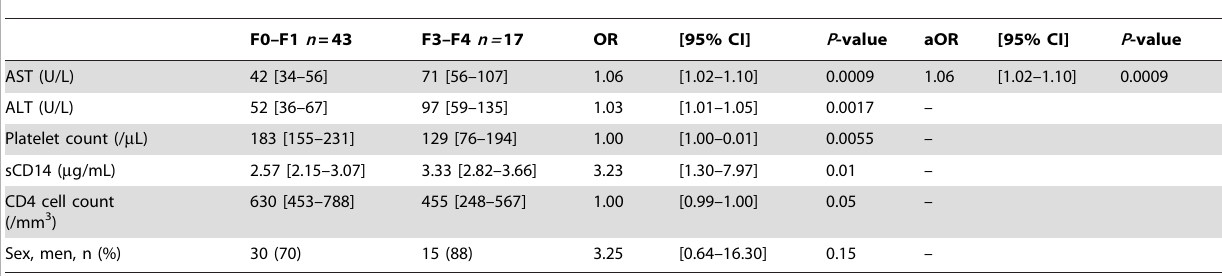
Table 2. Factors associated with the METAVIR liver fibrosis